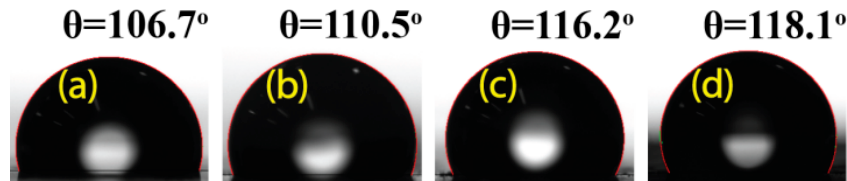
Figure 3. Water contact angles of water droplets on each sample. ( a ) PDMS; ( b ) S-PDMS; ( c ) SG- PDMS-I and ( d ) SG-PDMS-II. and ( d )